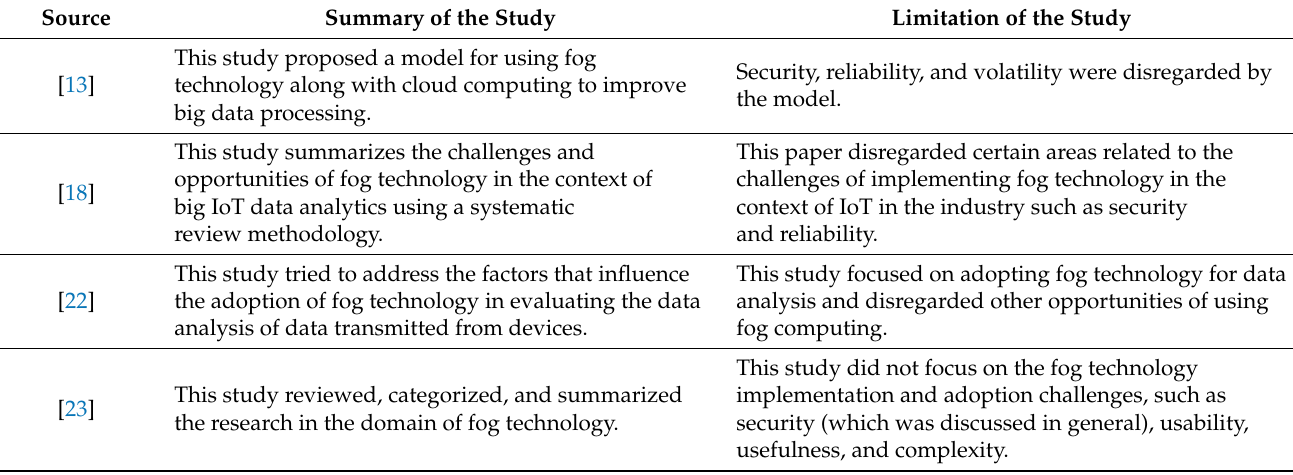
Table 1 highlights the summary and limitations of existing literature related to investi- gating the adoption of fog technology within organizations. Table 1. Summary of the